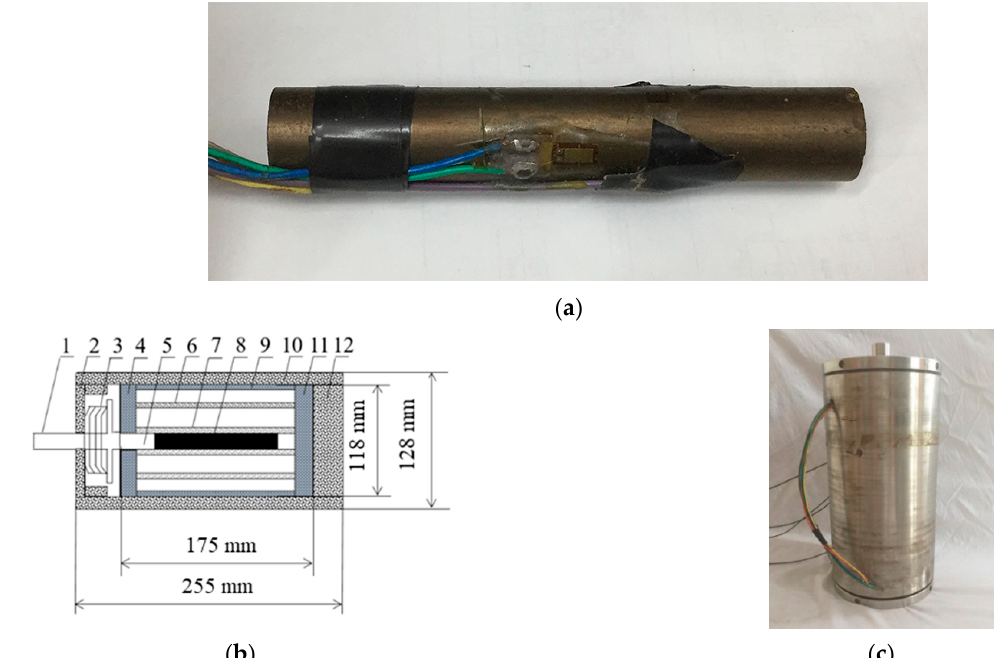
Figure 5. Giant magnetostrictive actuator. ( a ) Magnetostrictive rod. ( b ) The internal structure of GMA; 1- output rod; 2- nonmagnetic cover; 3- prepressing spring; 4- permeability cover; 5- magnetizer; 6-bias coil skeleton; 7- excitation coil skeleton; 8- Giant magnetostrictive material rod; 9- permeability wall; 10- non-magnetic outer wall; 11-permeability lower cover; 12- non-magnetic lower cover. ( c ) Manufactured GMA.